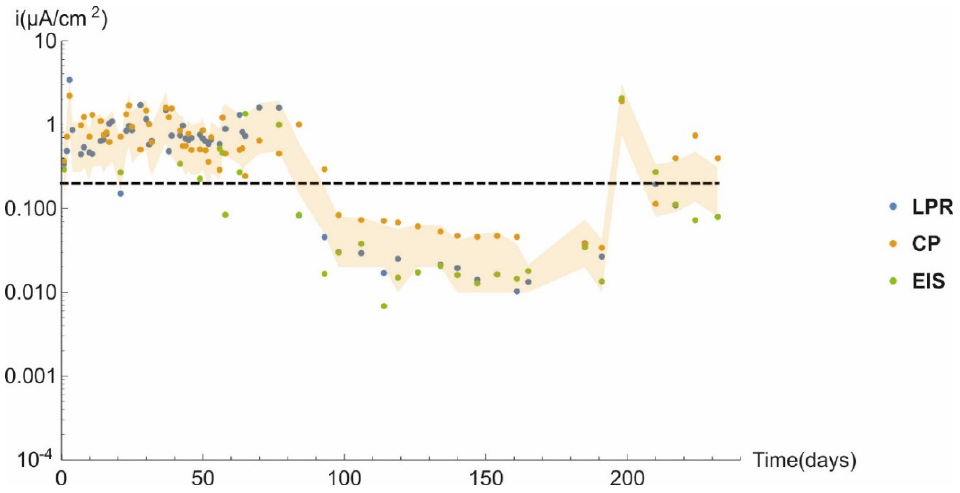
Figure 6. Corrosion rate over time in specimen E21.